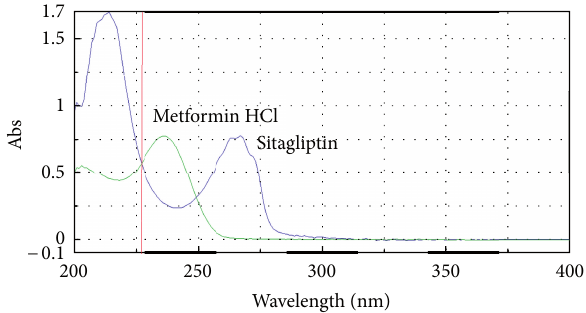
F 2: Spectra for MET (10